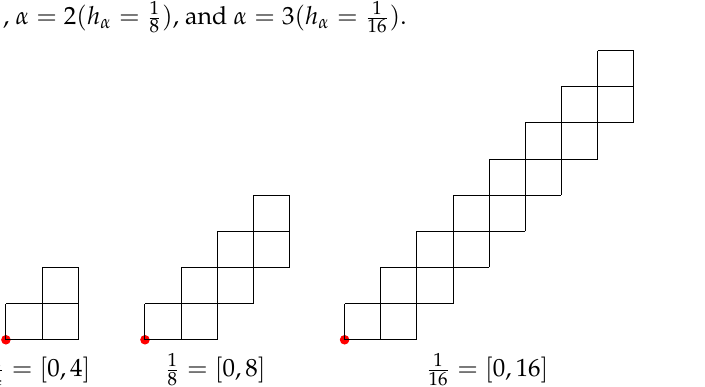
Figure 8. Examples of special snake graphs giving the minimal energy min E ( 1, C Γ j , h α ) , for j = 2, α =